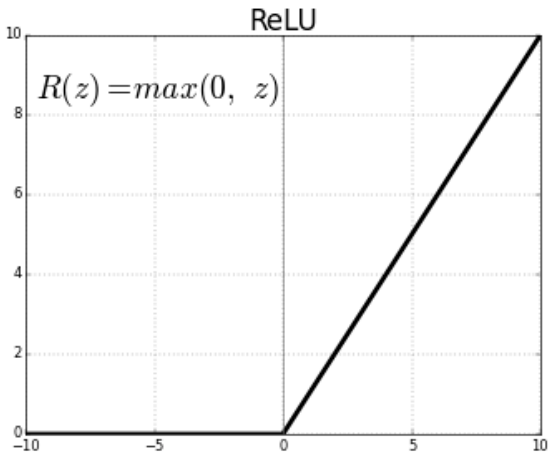
Figure 2. Rectifier function. Source: https://medium.com/@kanchansarkar/relu-not-a-differentiable-function-why-used-in-gradient-based-optimization-7fef3a4cecec (accessed on 15 October 2019).